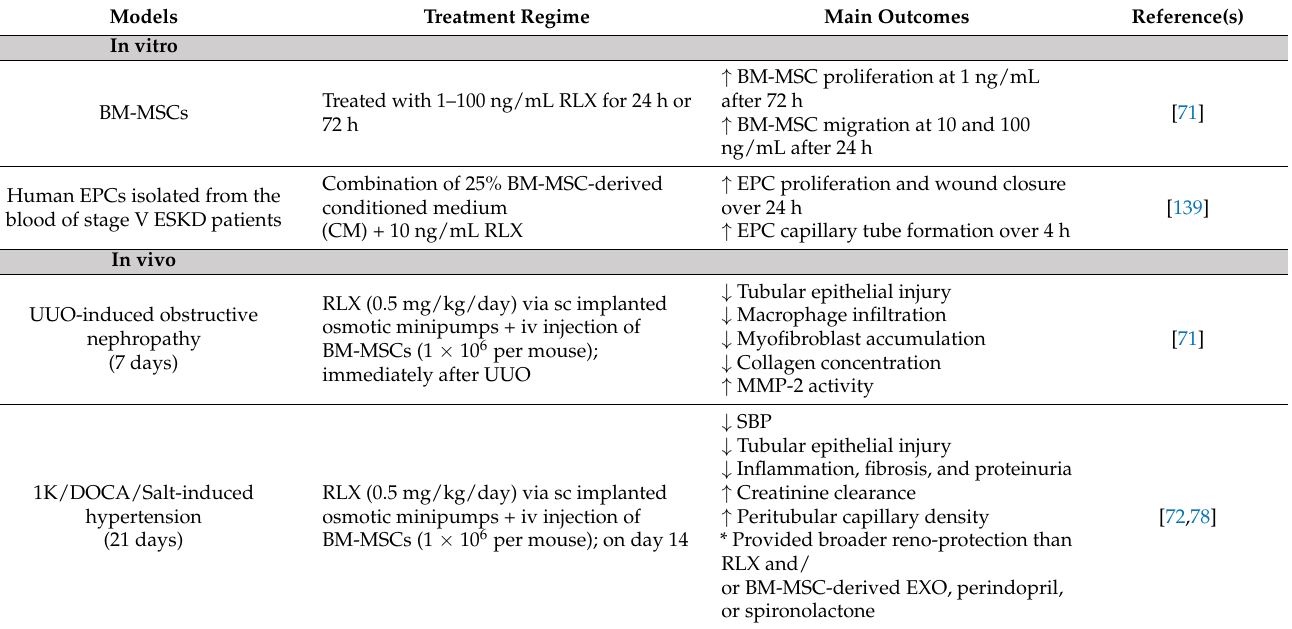
Table 4. Key findings from preclinical studies conducted to date that have evaluated the combined therapeutic effects of RLX and BM-MSCs in experimental models of